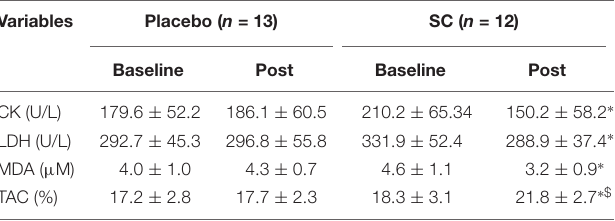
TABLE 3 | Comparison between placebo and supplementation groups on muscle damage and oxidative stress.